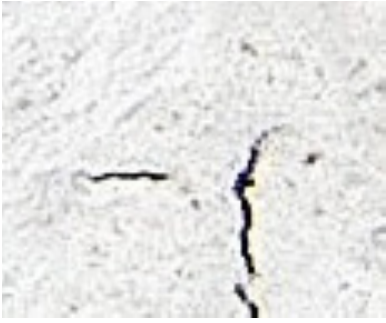
Figure 7. Cracking of the coating due to differential swelling of the wood and coating.